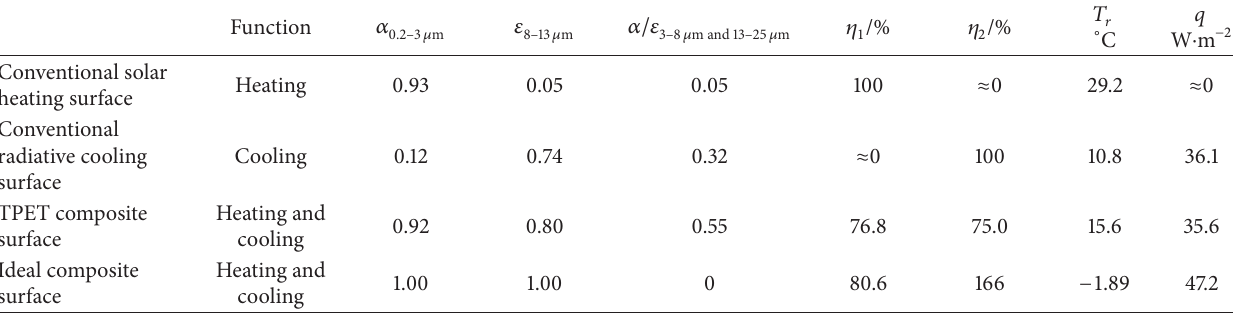
Table 1: Comparisons of the characteristics of each surface and their heating and cooling performances under typical summer environmental conditions of Hefei, China.